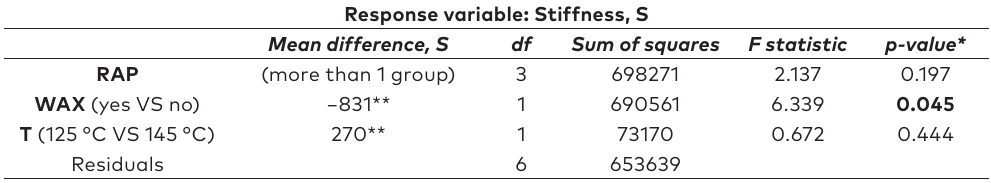
Table 4. Results from the ANOVA tests for asphalt mechanical